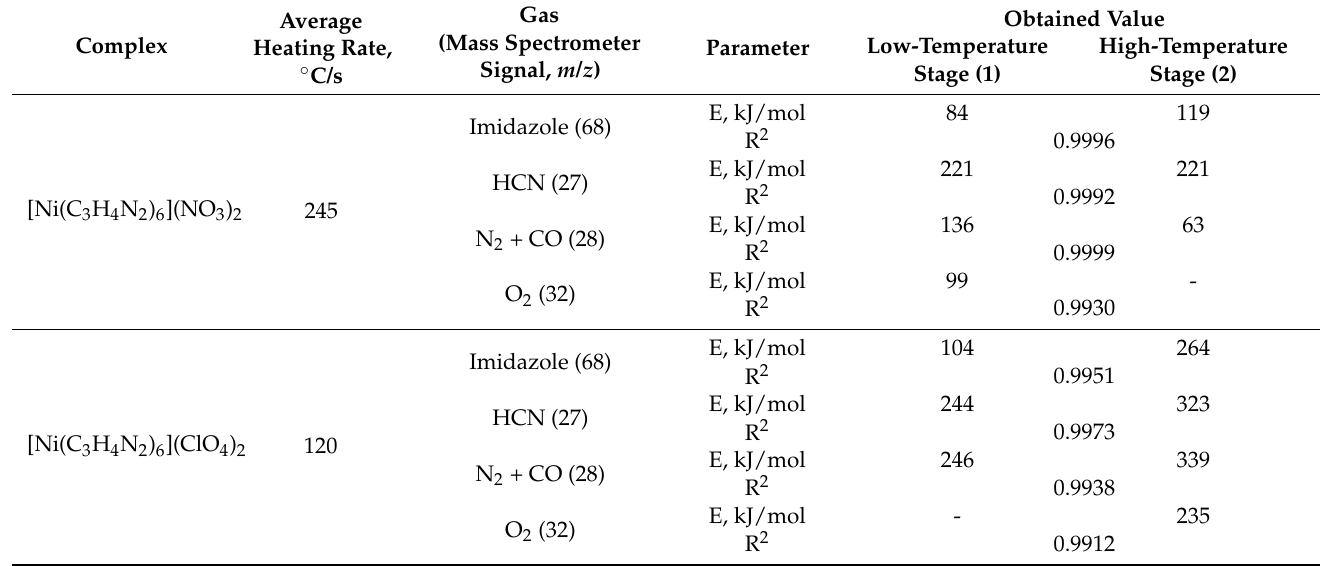
Table 4. The kinetic parameters of decomposition of the synthesized nickel complexes at the high heating